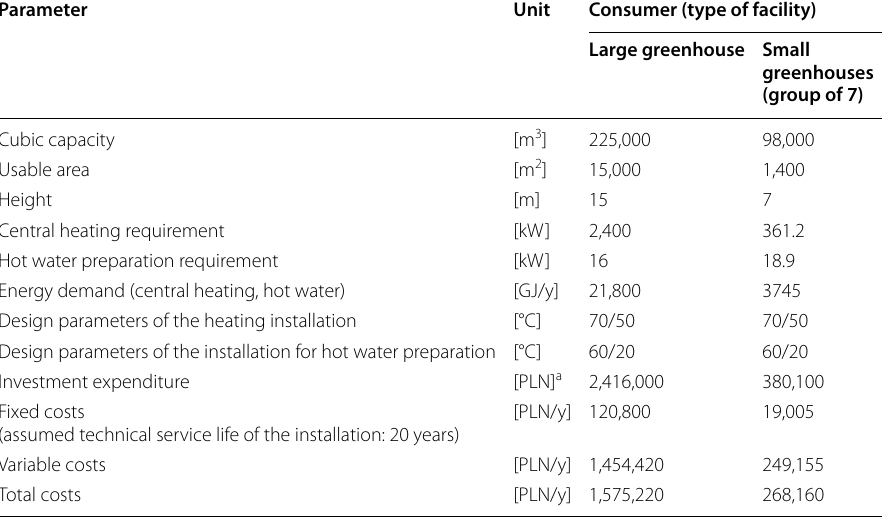
Table 1 Economic and energy evaluations for a large greenhouse and a group of seven small greenhouses assumed to be supplied by heat extracted from geothermal water; Central part of the Polish Lowlands, Uniejów‑Poddębice zone (Barbacki et al.